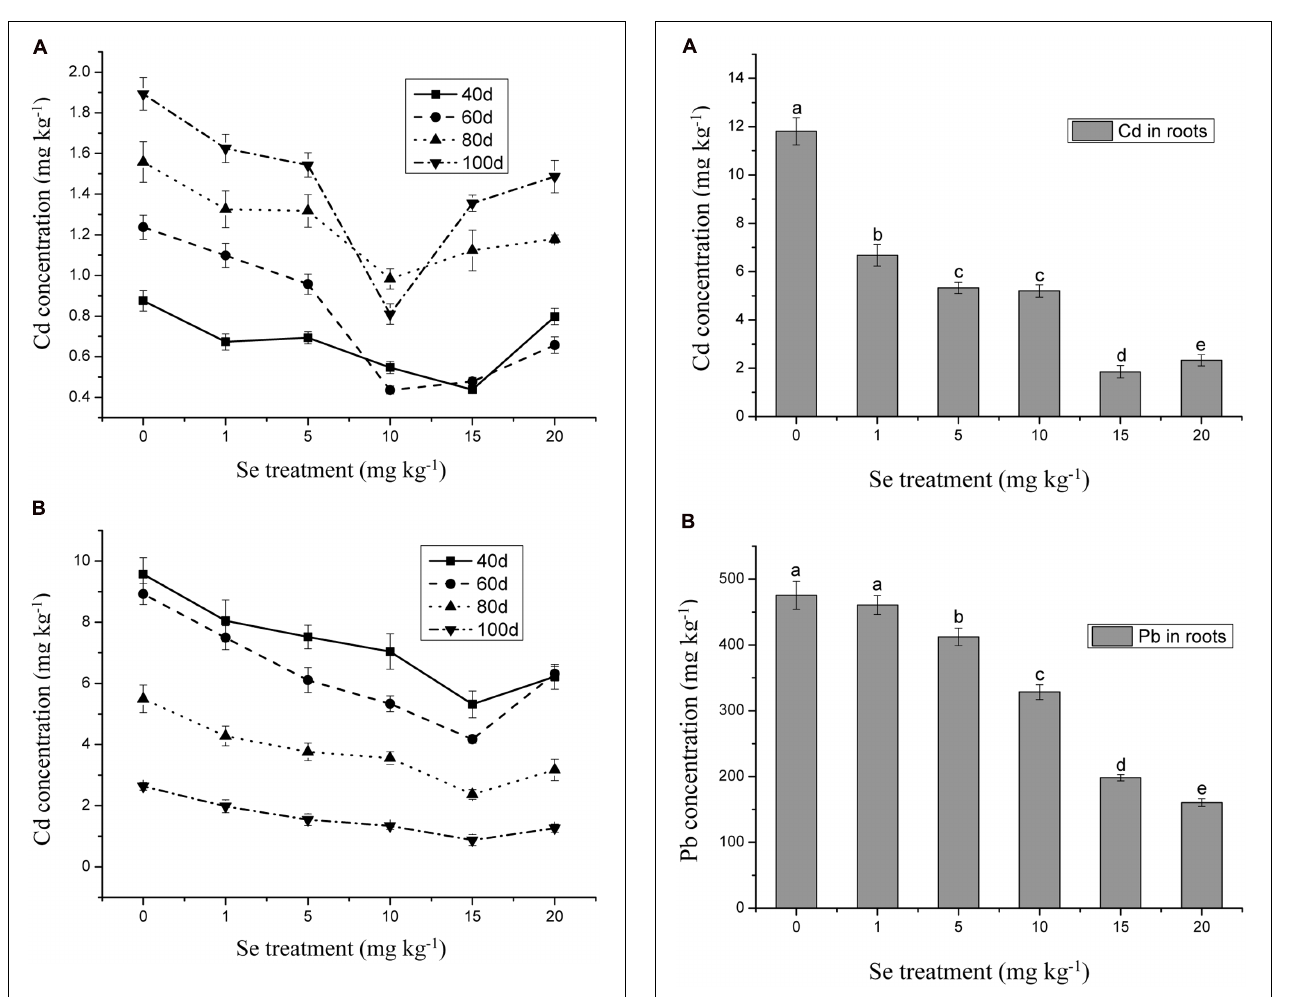
FIGURE 4 | (A) Concentration of Cd in roots of oilseed rape treated with soil Se and 5 mg kg − 1 Cd after a planting time of 60 days. (B) Concentration of Pb in roots of oilseed rape treated with soil Se and 500 mg kg − 1 Pb after a planting time of 60 days. Average concentrations (Dry biomass weight, DBW) provided with error bars representing the standard error. Different letters mean significance of difference between the treatments ( p ≤